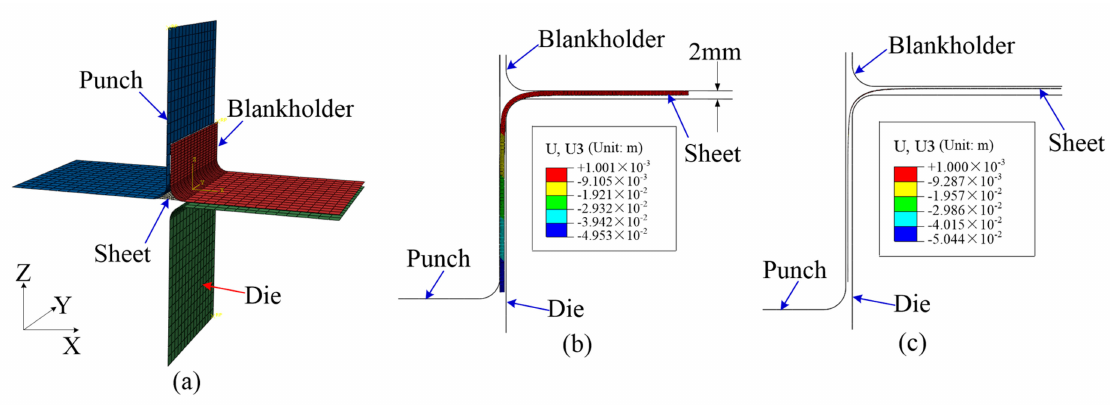
Figure 4. ( a ) 3D model of quasi-static stamping, ( b ) solid element, ( c ) shell